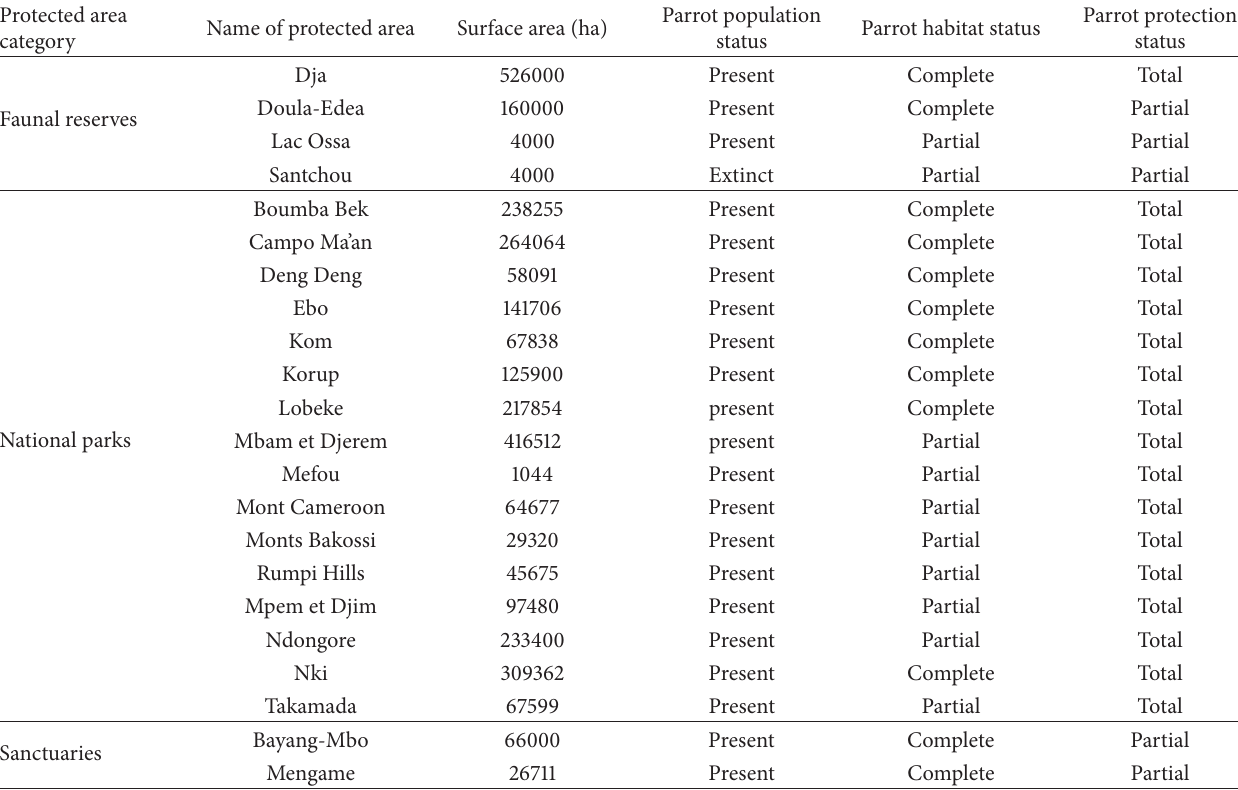
Table 2: Status of the Grey Parrot in national protected areas within the contemporary range of the bird species.